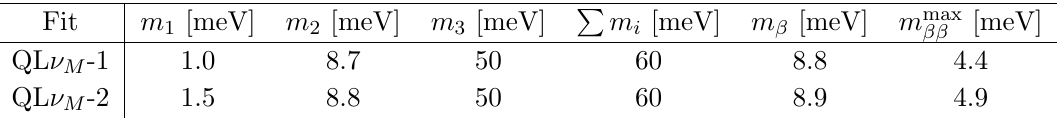
Table 11 . Predictions for neutrino masses and observables for the (cid:12)ts in table 10. Since the prediction for m (cid:12)(cid:12) strongly depends on possible phases in the PMNS matrix, here we display the maximal possible value m max . (cid:12)(cid:12)